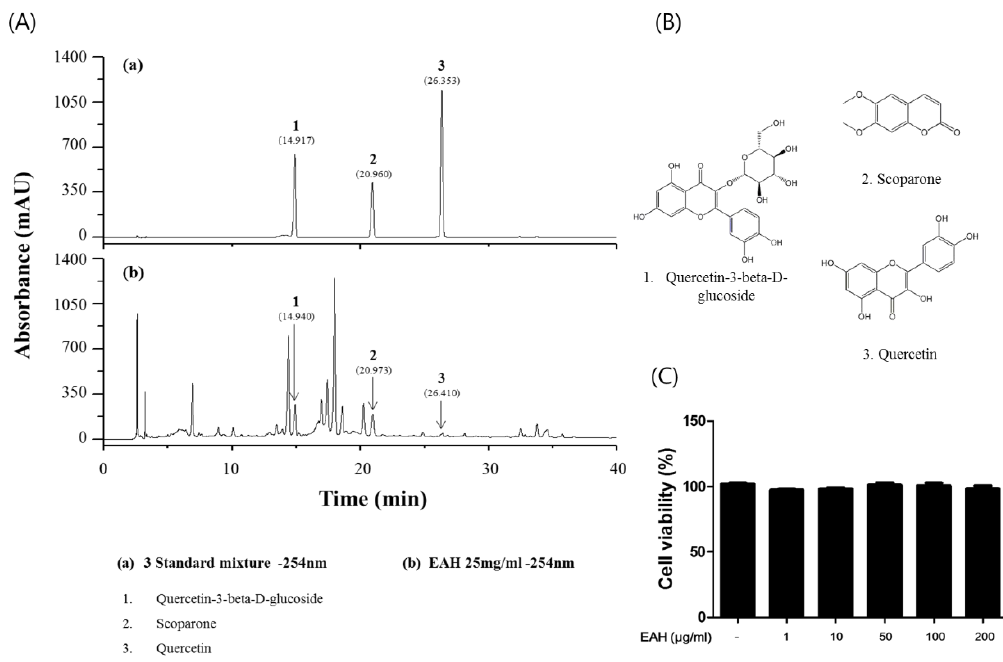
Figure 1. Measurement of representative components of extracts of Artemisia apiacea Hance (EAH) by HPLC analysis and cytotoxicity in HaCaT cells. ( A ) HPLC-DAD analysis chromatogram of three standard compound mixtures ( a ) and extract of Artemisia apiacea Hance (EAH) ( b ) that were identified at a wavelength of 254 nm. ( B ) Structures of the standard compounds. ( C ) Cell viability determined by 3-(4,5-dimethylthiazol-2yl)-2,5-diphenyl-2H-tetrazolium bromide (MTT) assay. The data are presented as the means ± SD of three experiments.